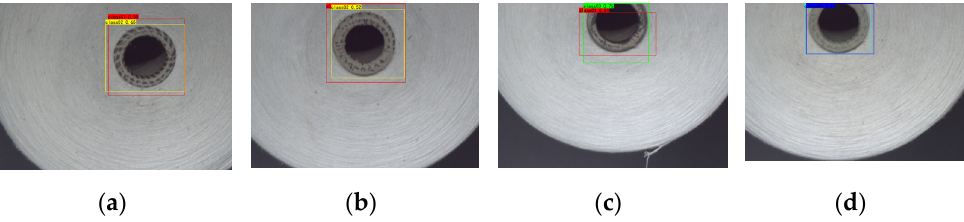
Figure 17. Incorrectly classified cone yarns: ( a ) cone yarn with black twill bobbin; ( b ) cone yarn with